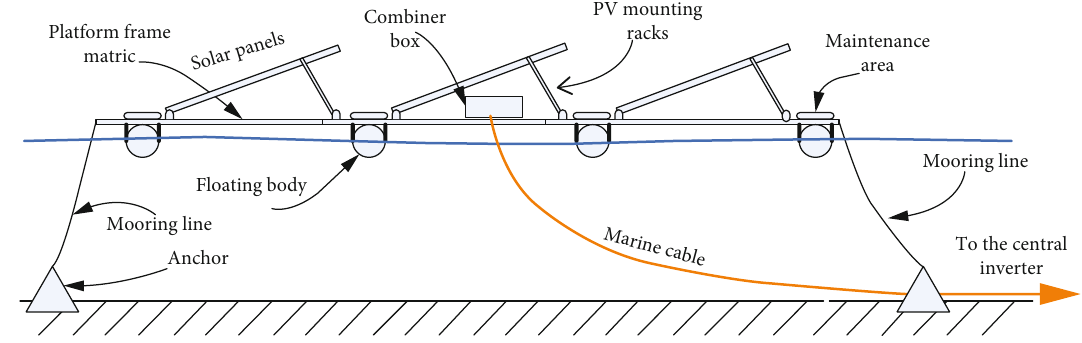
Figure 16: Components of a fl oating PV system.